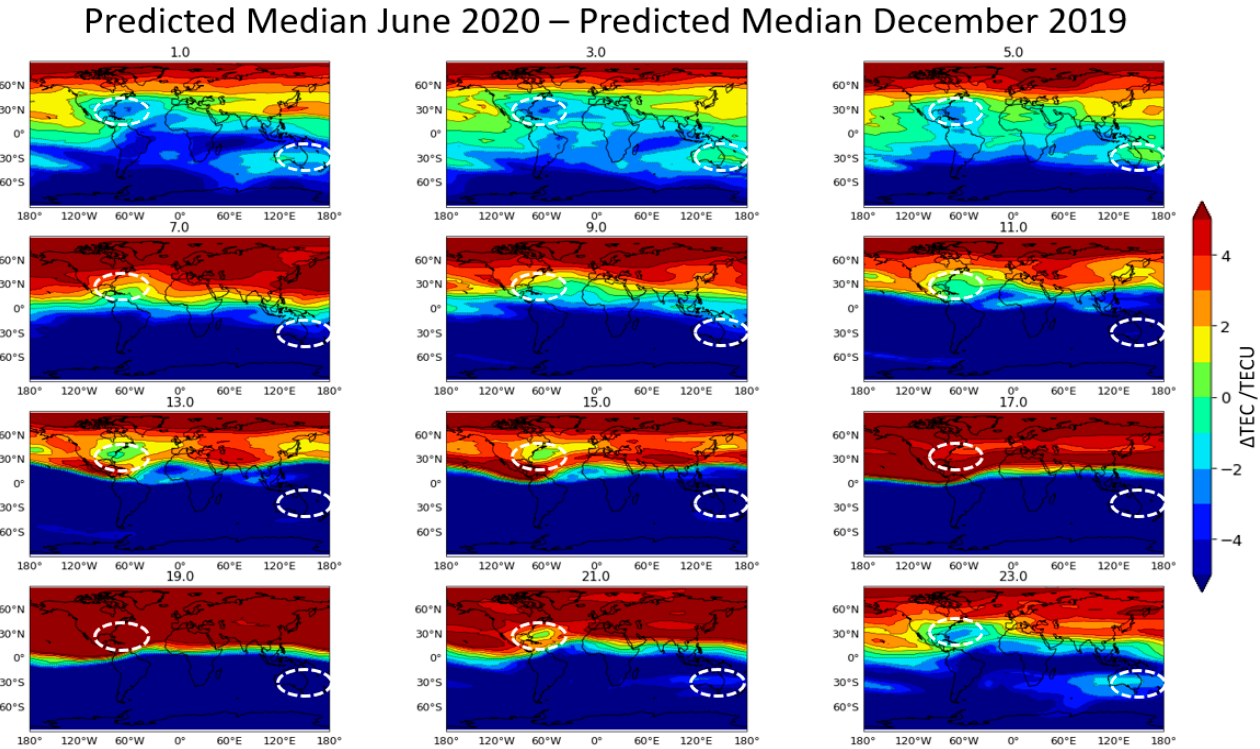
Figure 9. The formation of the NWA for all LTs every two hours computed with the GIM VTEC. The dashed white lines indicate the location of the NWA.